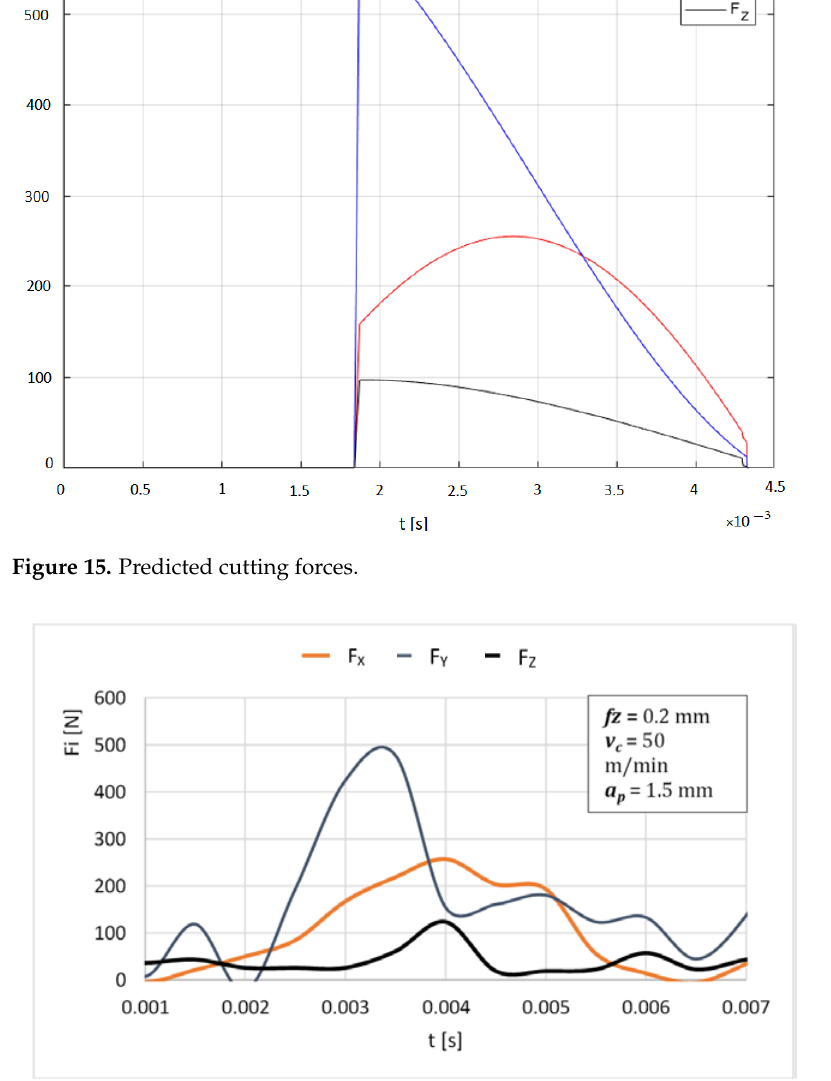
Figure 17. Brittle fracture tool wear occurring during machining. Magnification × 12. The influence of the tooth feed on the cutting forces for each of the previous machin- ing types was analyzed. The results were compared on the graph (Figure 18). In the case of the Fx force, its values are similar between slot-milling and turn-milling; however, at the highest feed, the Fx turn-milling force increases significantly. A significant increase can also be observed in the other directions. With these parameters, brittle fracture of the edge also occurred most often, and it should be assumed that it is not possible to perform machining with these parameters. Regardless of the machining strategy, the impact of